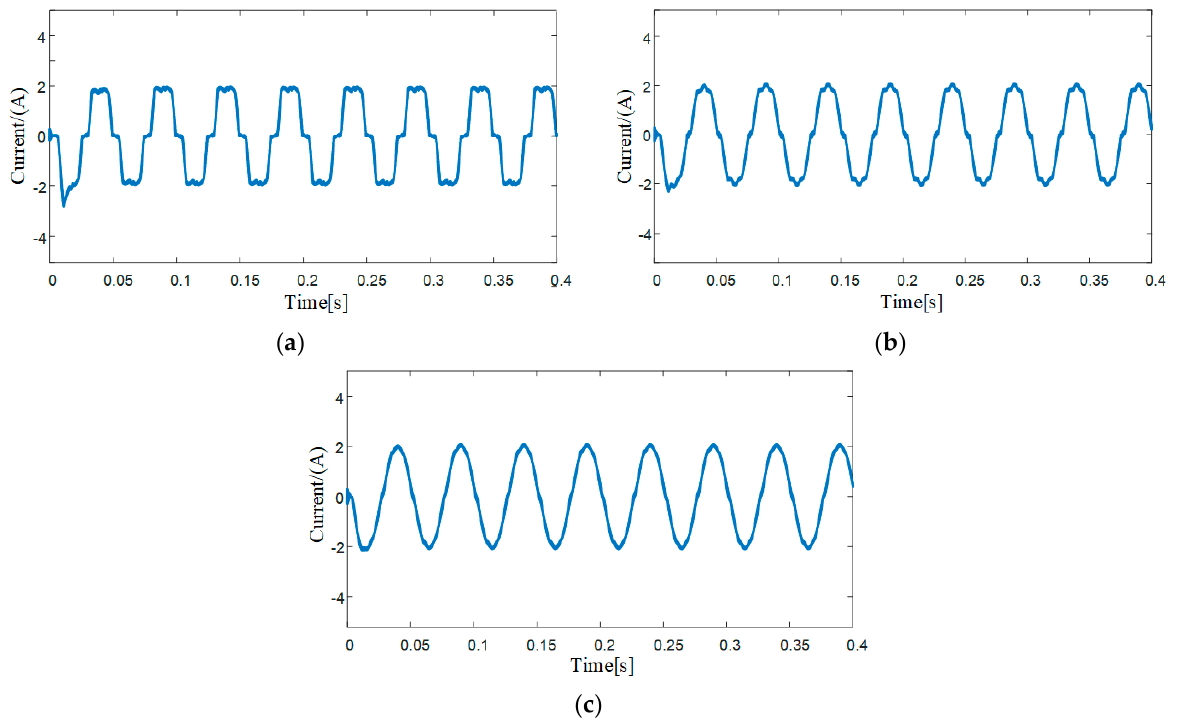
Figure 13. Phase current waveform: ( a ) No dead zone compensation; ( b ) the traditional linear dead zone compensation; ( c ) the improved linear dead time compensation.